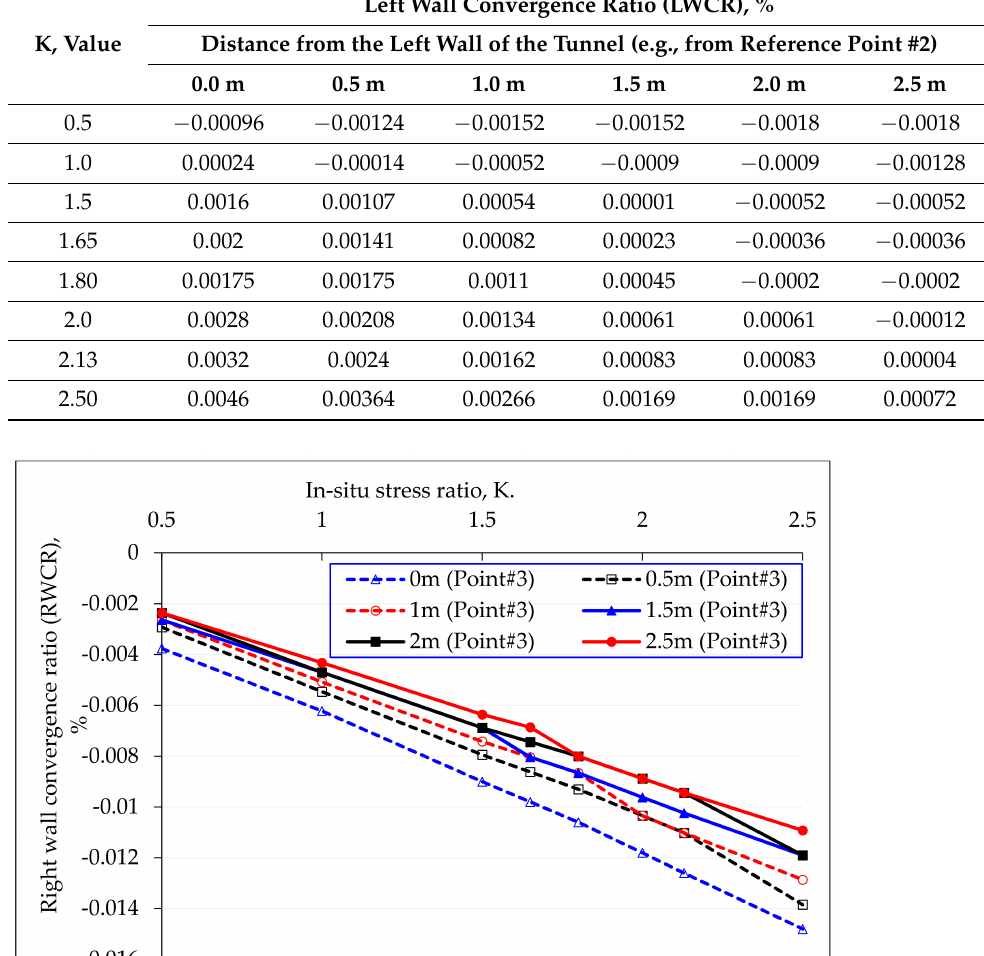
Table 4. Ratio of left wall convergence (LWCR) at various in situ stresses and different distances from the left wall of the tunnel (e.g., from reference point #2).